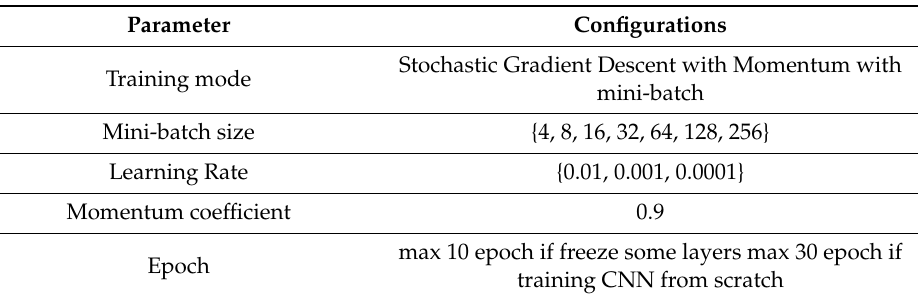
Table 2. Hyperparameters grid